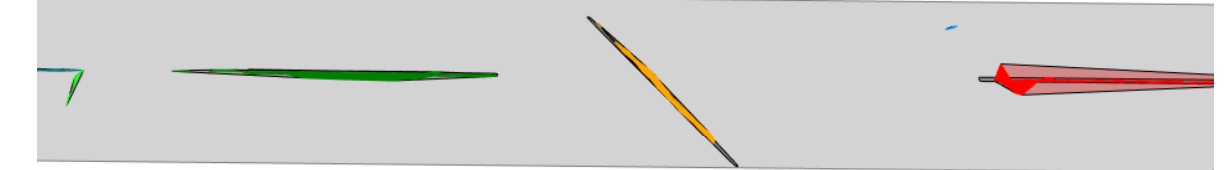
Figure 20. Road spot 4. Crack clusters detected with the proposed algorithm, delimited with both convex hulls ( light color ) and alpha-shapes ( intense color ). Boxes in grey delimit the manually segmented cracked areas.